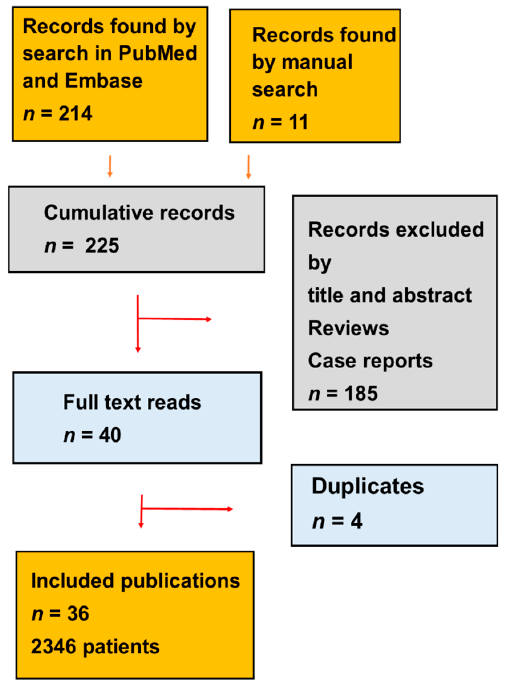
Figure 1. The PRISMA (The Preferred Reported Items in Systematic review and Meta-Analysis) flow diagram shows the selection process in the systematic